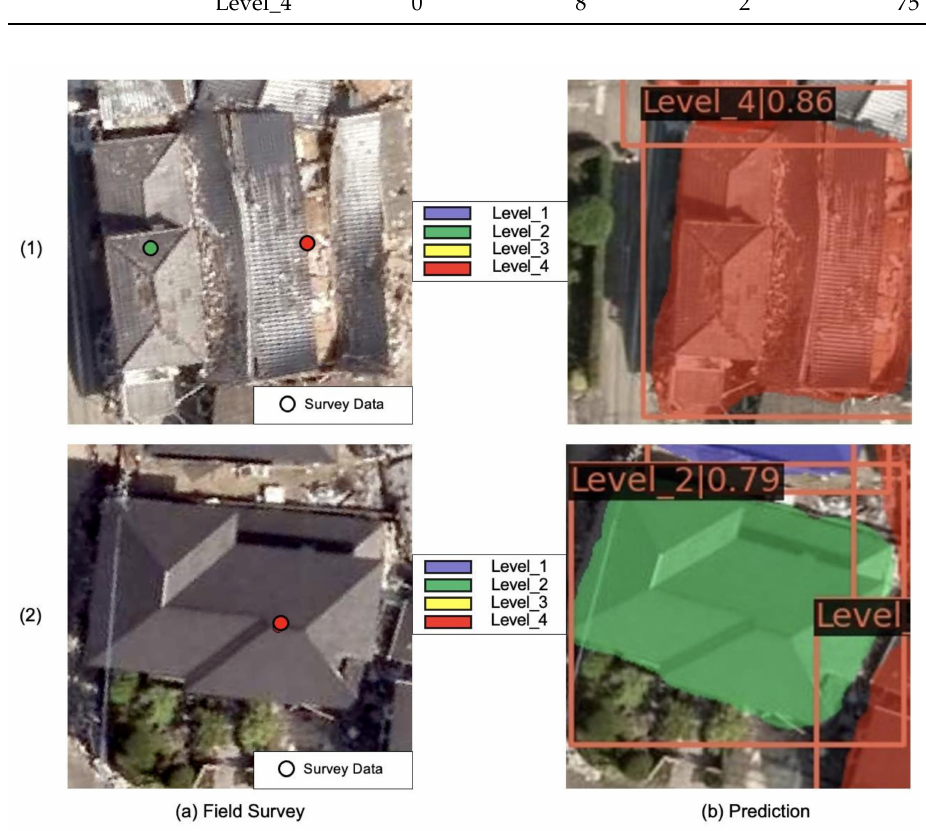
Figure 10. Misclassification situations of the proposed